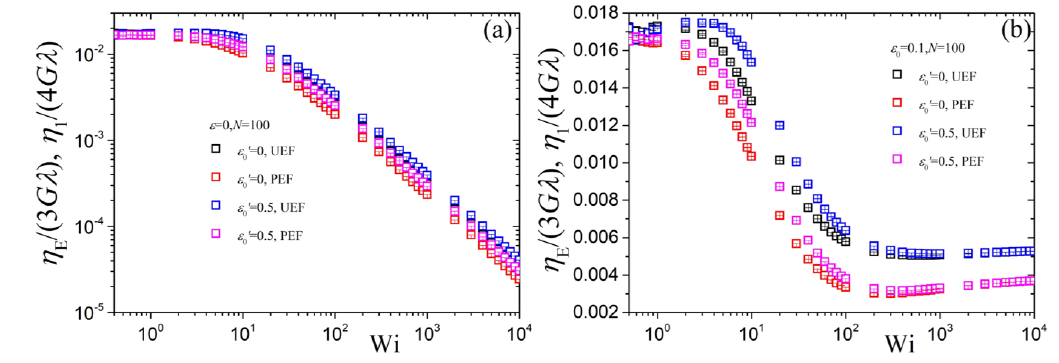
Figure 5. Comparison of the predictions for the first planar η 1 ( ˙ (cid:101) ) /4 G λ (black, blue, denoted as PEF in the legends) and uniaxial η E ( ˙ (cid:101) ) /3 G λ (red, pink, UEF) reduced viscosities as a function of dimensionless elongation rate Wi for N = 100 and two values of the parameter ε (cid:48)